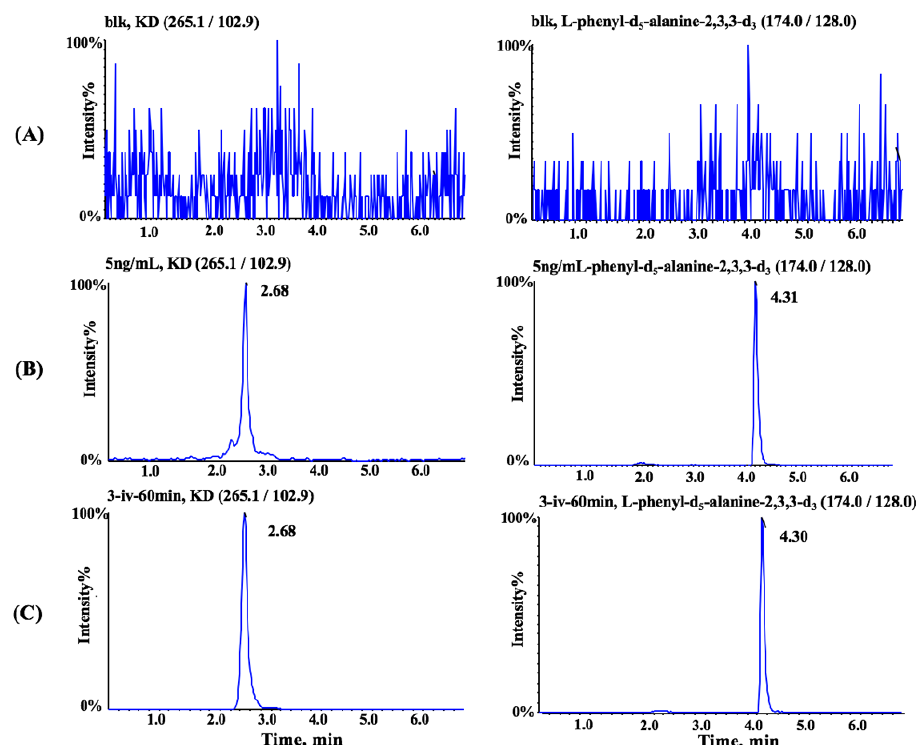
Figure 4. Typical multiple reaction monitoring (MRM) chromatograms of kinsenoside ( left ) and internal standard ( right ) in ( A ) blank dog plasma, ( B ) plasma sample at the LLOQ level, and ( C ) plasma sample obtained 1 h after intravenous administration of 3 mg/kg of kinsenoside.